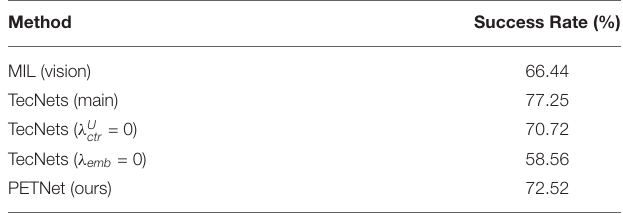
TABLE 1 | Performance at meta-test of sim-push task.